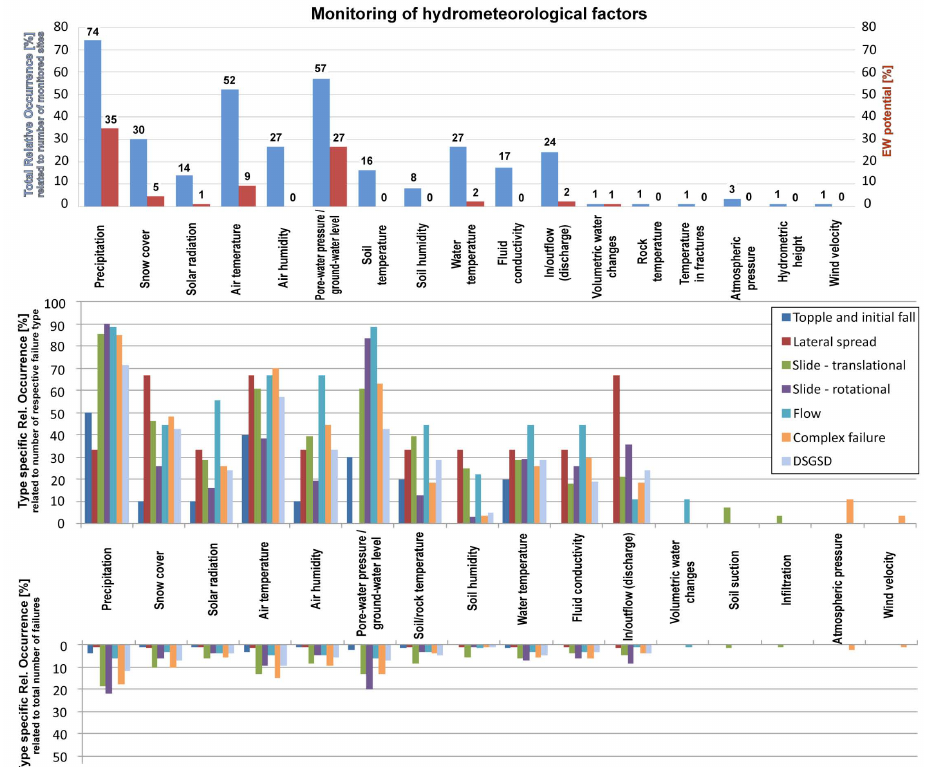
Fig. 10. Review of total relative occurrence, EW potential and type-specific relative occurrence of hydro-meteorological monitoring param- eters from the 86 monitored landslide